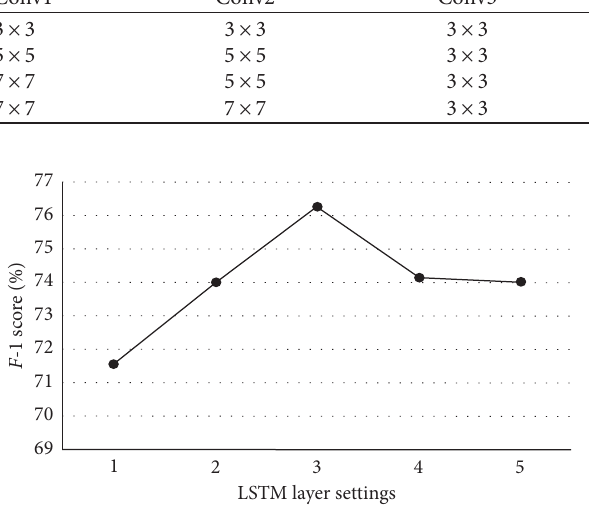
Table 3: F -1 scores of STCN models under different size convolution kernels configurations. Conv1